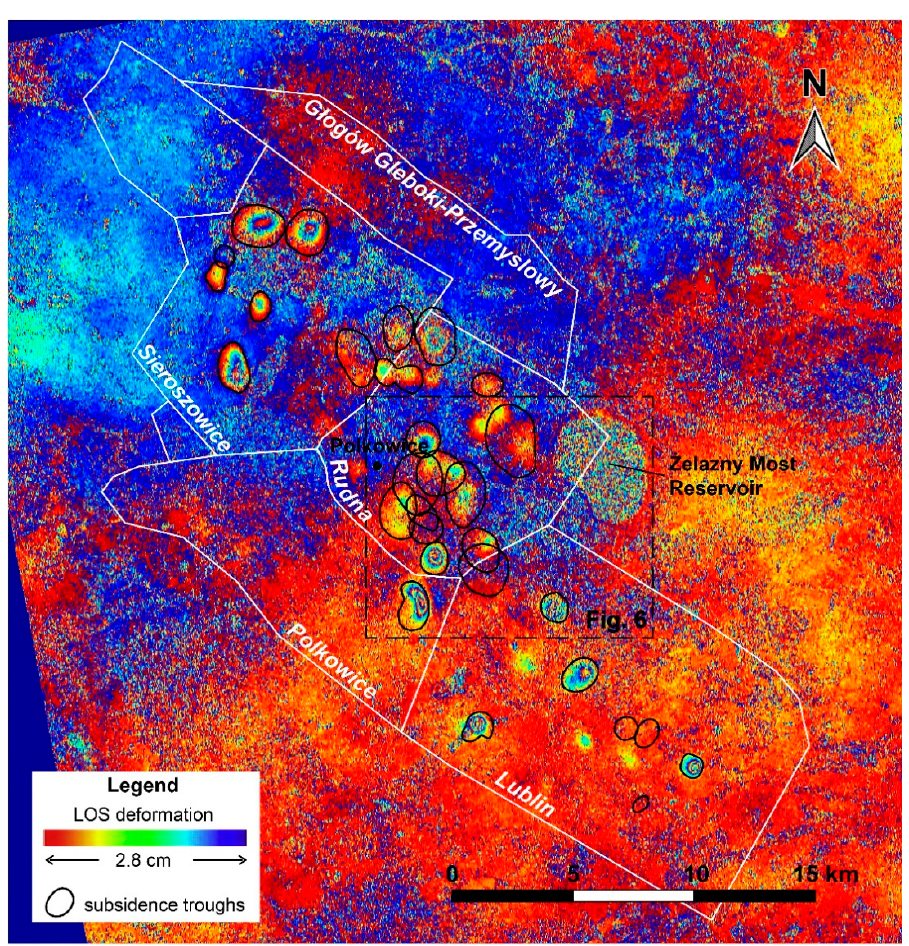
Figure 5. Sentinel 1 C-band differential interferogram, dates: 14 January 2015–3 March 2015; white lines represent LGCD mine district borders. The perimeter of the subsidence troughs was mapped during the whole analyzed time span (October 2014–April